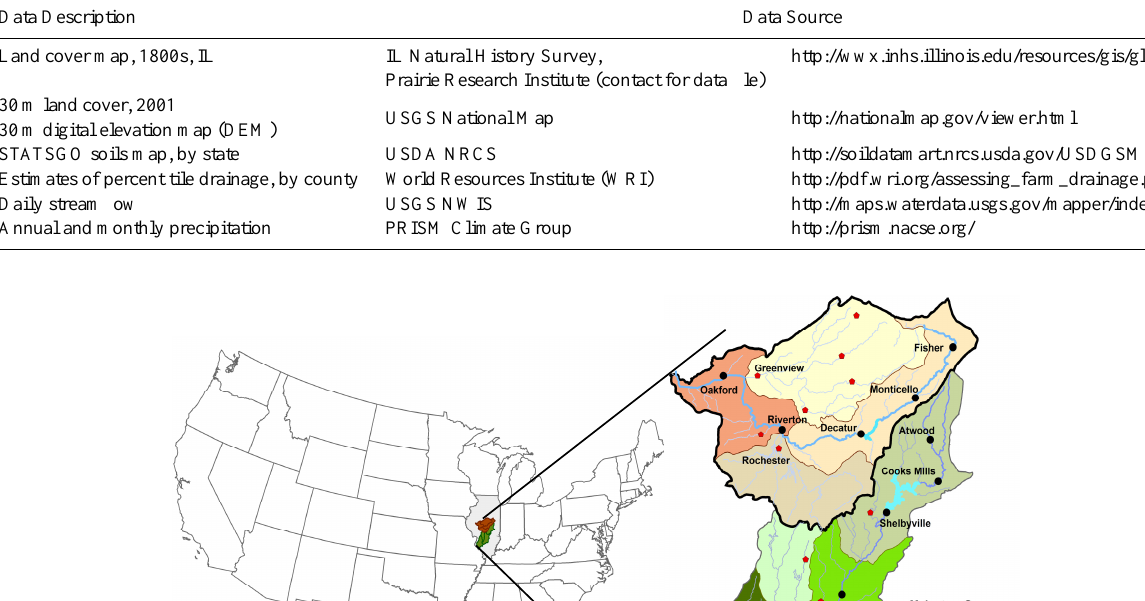
Table 1. Description of and sources for all data used in this study.